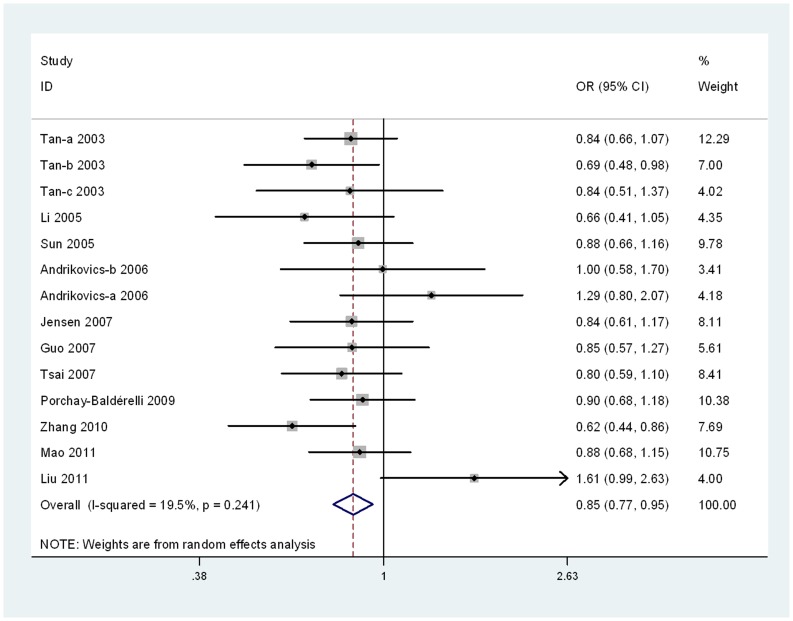
Forest plot for ABCA1 M883I polymorphism and AS risk in the allelic model (I allele vs. M allele).